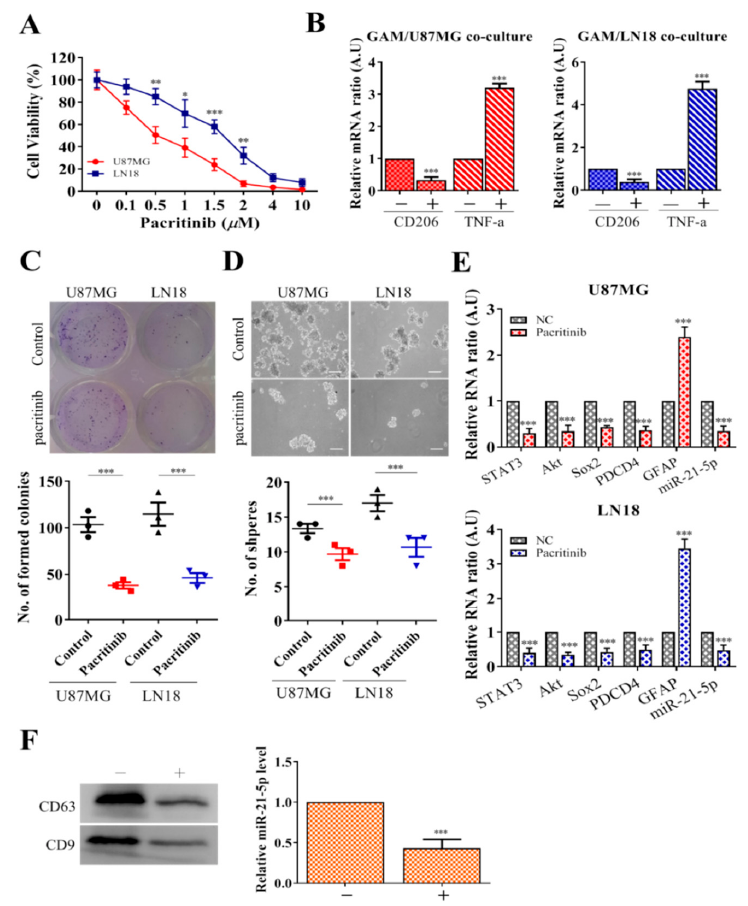
Figure 5. Pacritinib treatment suppresses GBM tumorigenesis and glioma stem cell (GSC) properties. ( A ) Pacritinib treatment significantly suppressed both U87MG and LN18 cells (approximate IC